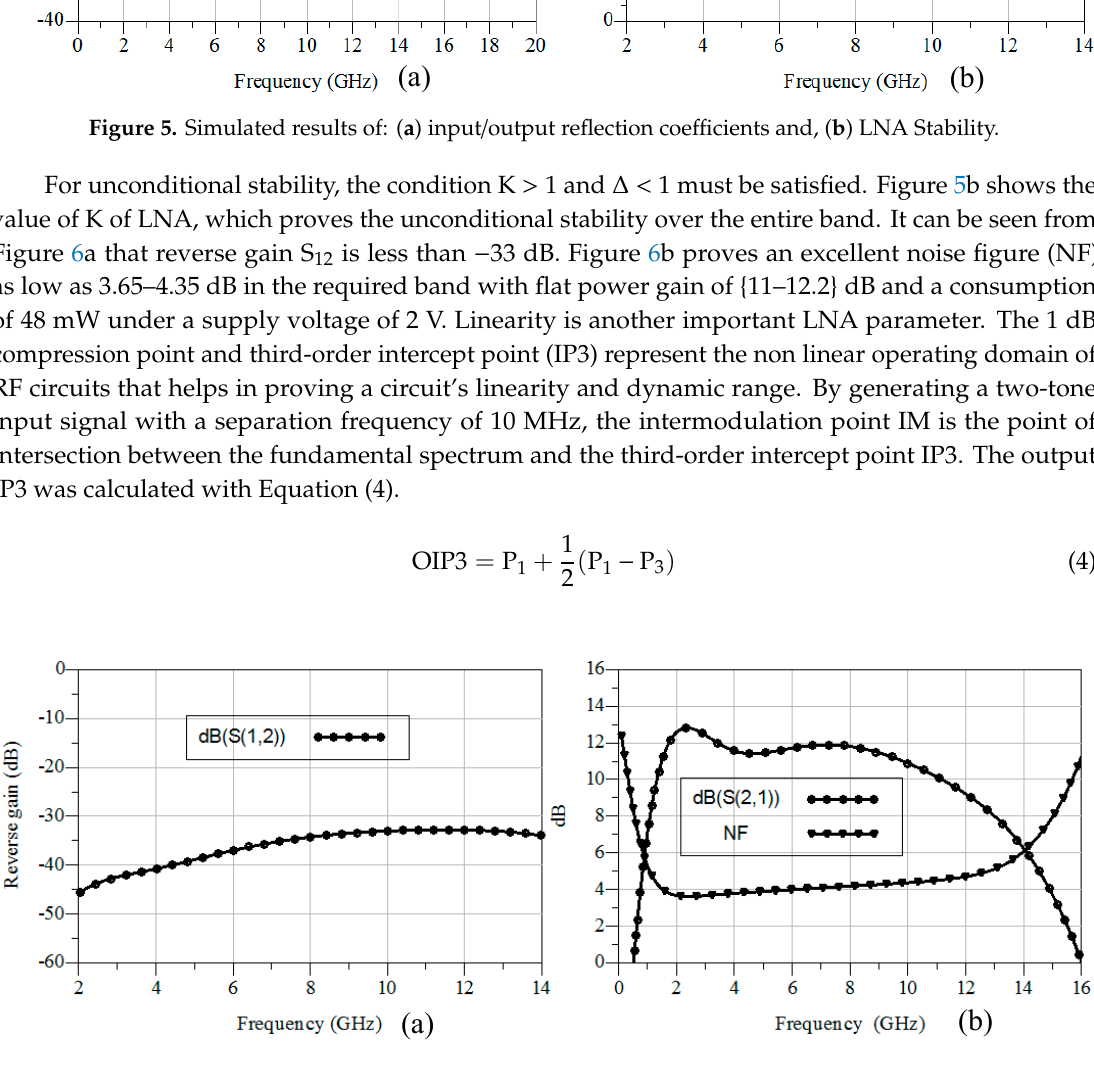
Figure 6. Simulated results of: ( a ) isolation, and ( b ) Simulated results of power gain and noise figure (NF). Figure 7. Simulated results of: ( a ) compression point 1 dB, and ( b ) Interception point (IP3).